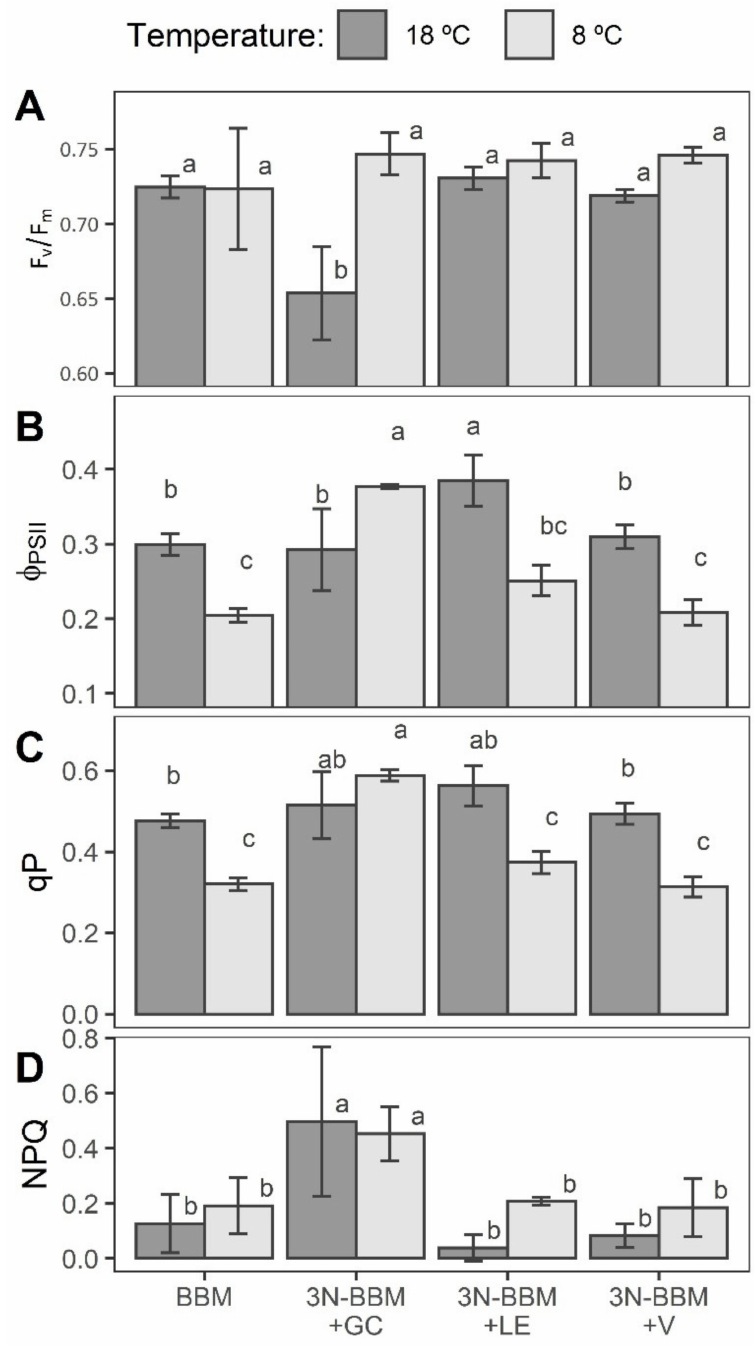
Figure 7. Chlorophyll a modulated fluorescence analysis of Diplosphaera elongata sp. nov. grown on different media and at different temperatures: ( A ) F v /F m , maximum quantum efficiency of PSII pho- tochemistry; ( B ) ϕ PSII , effective quantum yield; ( C ) qP, coefficient of photochemical quenching; and ( D ) NPQ, non-photochemical quenching parameter. Bars with the same letter are not statistically dif- ferent (two-way ANOVA analysis, post hoc Tukey HSD test; p < 0.05; data represent mean ± standard deviation; n =